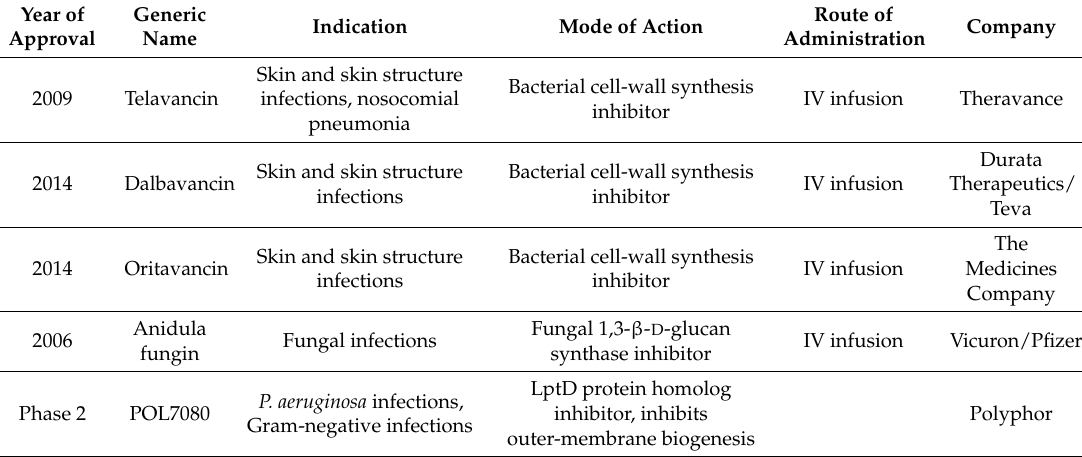
Table 1. Cyclic peptide antibacterial drugs approved by the Food and Drug Administration (FDA).